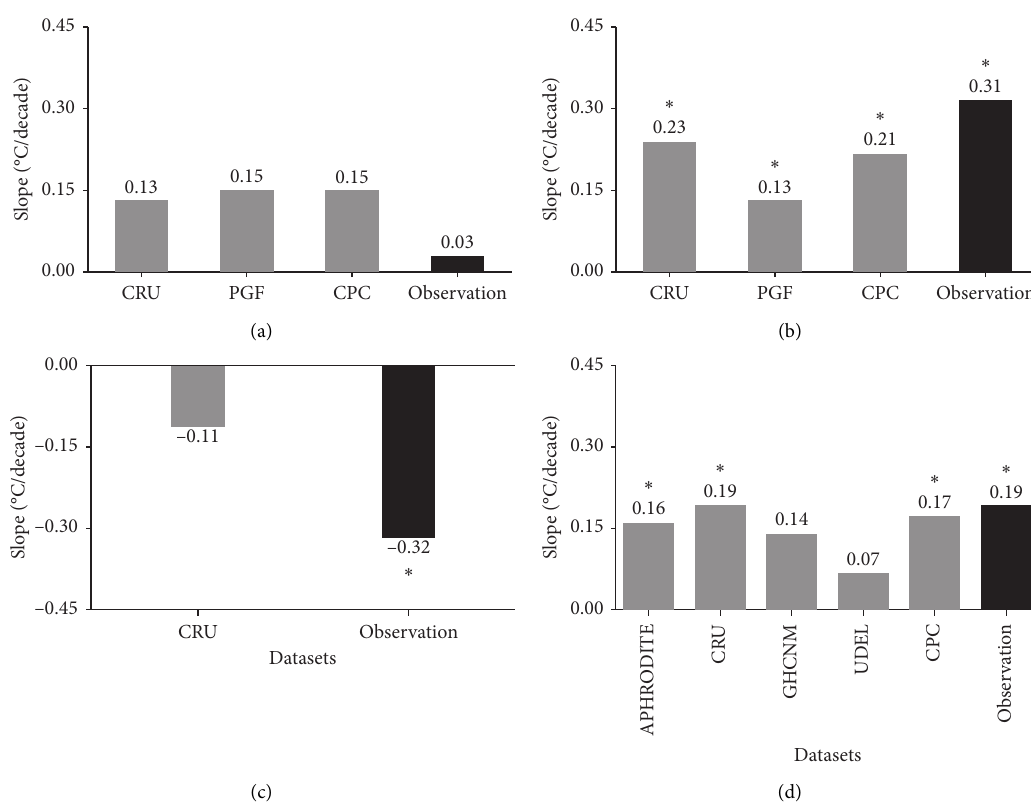
Figure 7: Comparison of MK trend slopes ( ∗ significant trend at 95% CI) of the observation data and GDPs for (a) T and (d) T mean